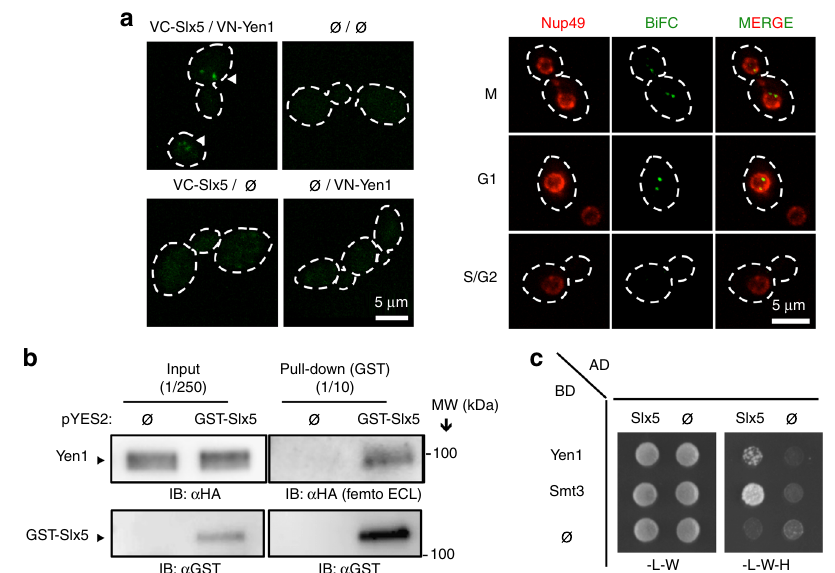
Fig. 2 Yen1 interacts with Slx5 – Slx8 in the nucleus. a Diploid strains carrying one allele of galactose inducible VC-Slx5 and VN-Yen1 with wild-type copies of YEN1 and SLX5 in the homologous chromosomes were observed by live microscopy. BiFC (white arrows) signal denotes an interaction between the two BiFC (Venus) epitopes. Control diploids lacking one or both of the epitope-tagged proteins ( ϕ ) were used to substract background signal. A plasmid carrying Nup49-mCherry was transformed on the diploid strain harboring VC-Slx5/VN-Yen1 to visualize the nuclear perimeter. BiFC interactions were only detected in the nuclear compartment. b Cells carrying either an empty vector or a pYES2 plasmid expressing GST-Slx5 under galactose control were grown in selective media and induced with galactose for 3 h. Lysates were then applied to a glutathione-sepharose column. After washing, the bound proteins were eluted and immunoblotted with α -HA (upper) or α -GST (lower). c Two-hybrid assays were performed with strains carrying the indicated activating domain (AD) or DNA binding domain (BD) fusions. Strains were grown in selective media lacking leucine (L) and tryptophan (W) prior to spotting on media lacking histidine (H) to detect a positive interaction. Experiments were independently replicated three times and images are representative of